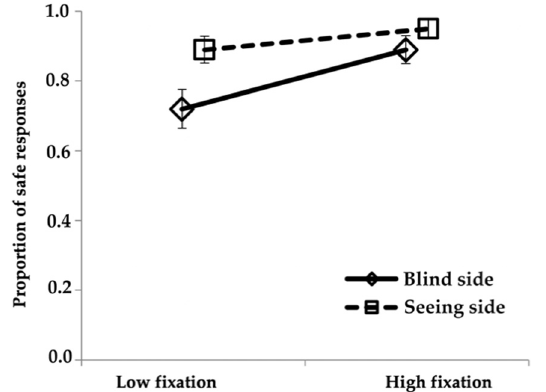
Figure 10. Proportion of safe responses for HVFD participants by whether it was a high or low fixation event and whether the crossing was from the participant’s blind or seeing side (mean, SEM).